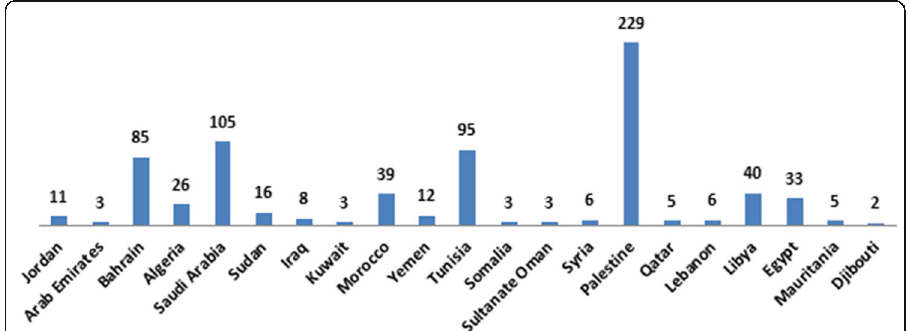
Fig. 1 Country distribution of the